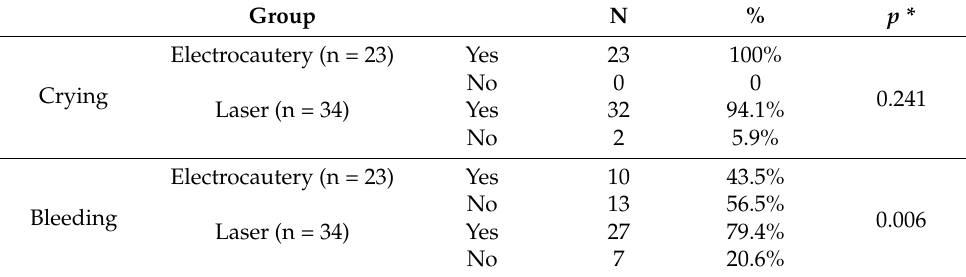
Table 4. Postoperative